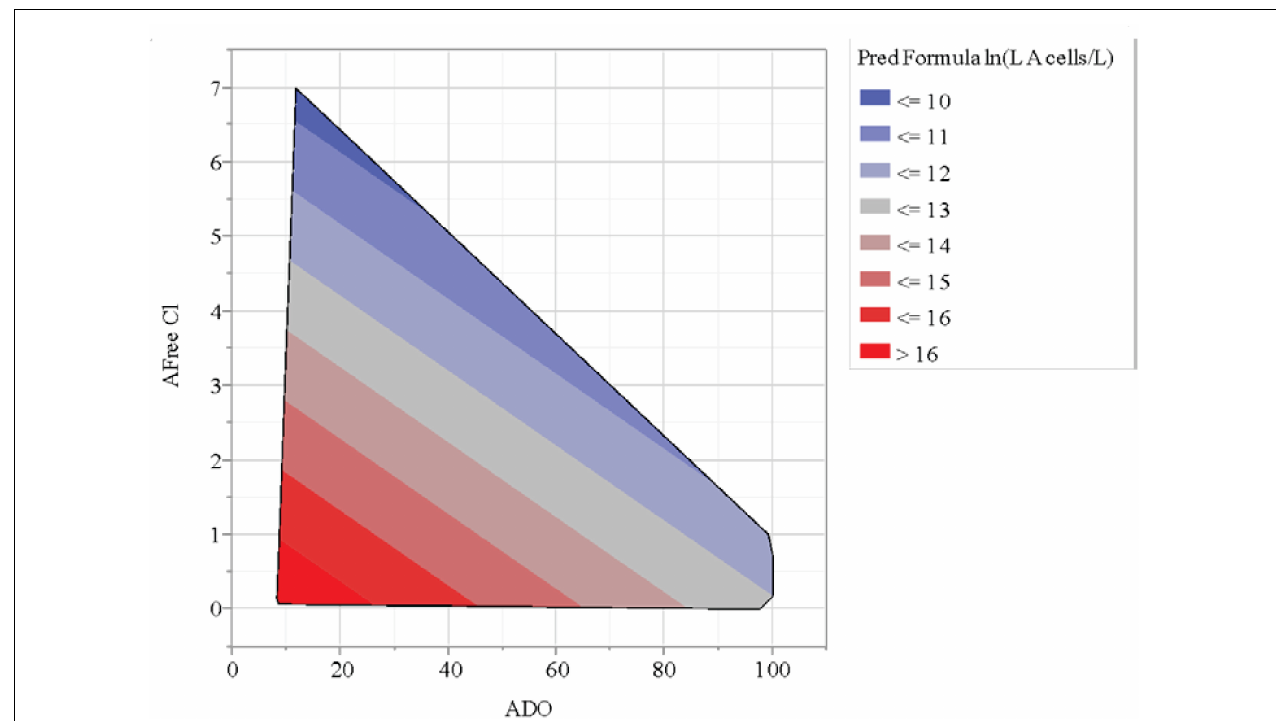
FIGURE 4 | Contour plot of chlorine (Cl) and dissolved oxygen (DO) relationship with L. pneumophila concentrations (cells/L).